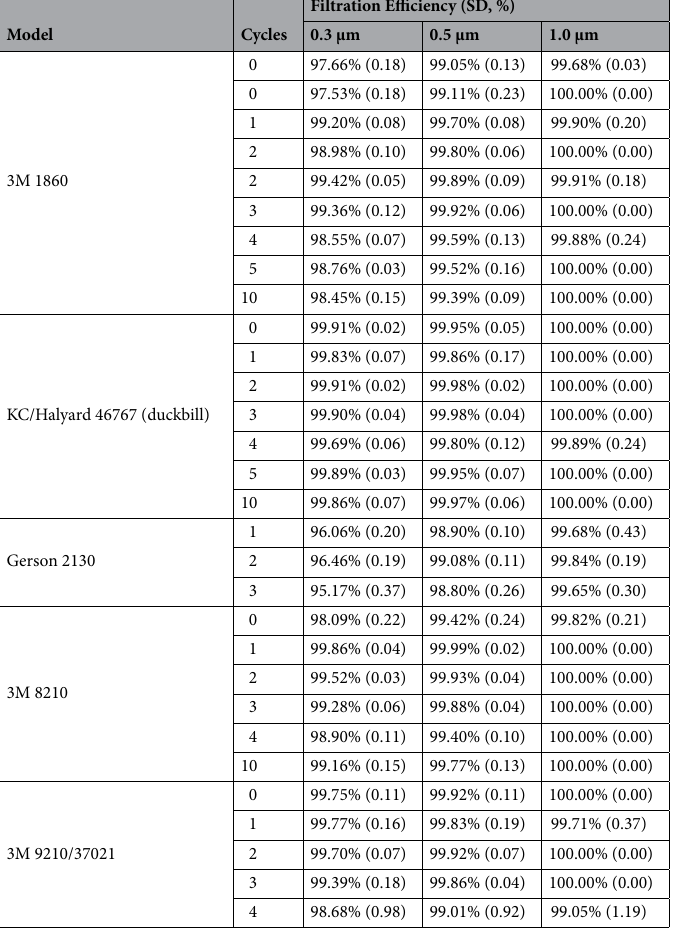
Table 2. Results obtained at a university laboratory on single-pass filtration efficiency for ambient particle matter. Each row represents a single N95 mask. Filtration efficiency values are an average of four upstream and downstream measurements. Standard deviations are calculated from repeat measurements made on a single